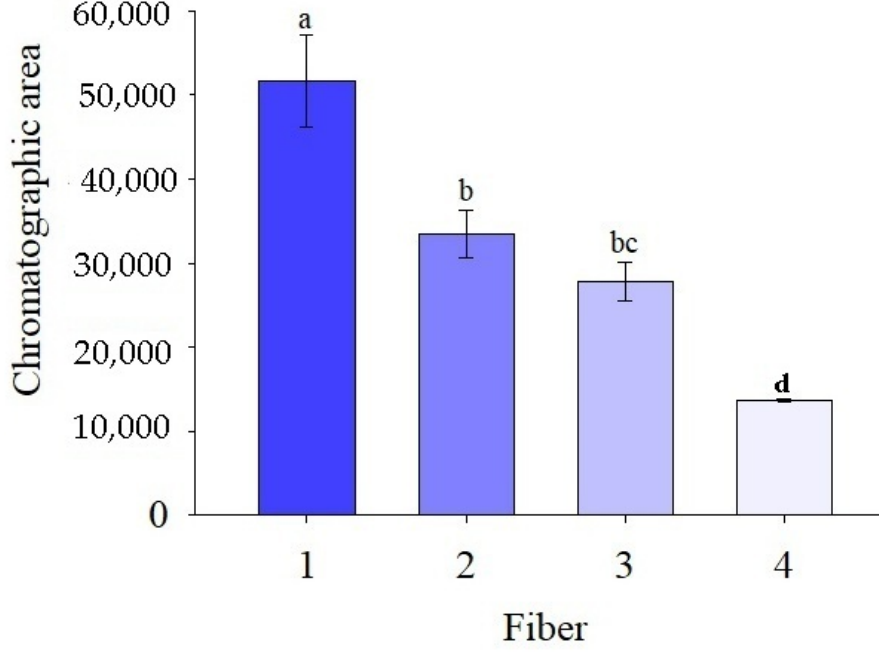
Figure 2. Safrole extraction from cowpea beans by headspace solid-phase microextraction coupled to a gas chromatograph with a flame ionization detector using the fibers: (1) 50/30- µ m divinylben- zene/carboxen/polydimethylsiloxane (DVB/CAR/PDMS) StableFlex, (2) 85- µ m polyacrylate (PA), (3) 100- μ m PDMS, and (4) 7- μ m PDMS. Sample mass: 5.0 g; extraction: 30 °C for 3 min ( n = 3). The same letters are not significantly different by Tukey’s test ( p < 0.05).